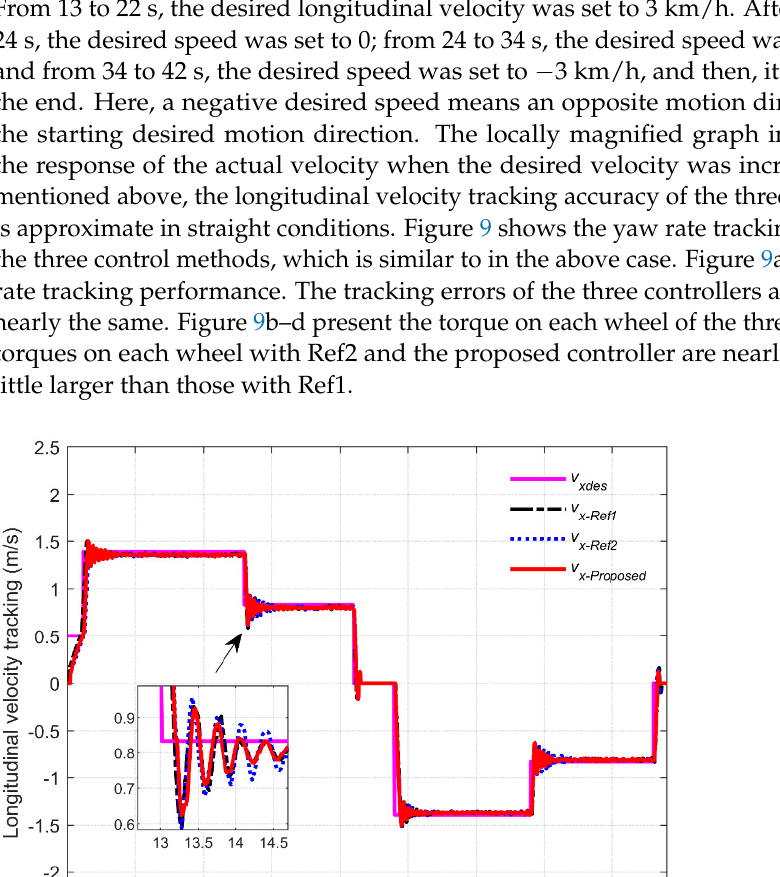
( d ) Figure 9. Comparison of yaw rate and the desired torque on each wheel with three controllers: ( a ) Comparison of yaw rate; ( b ) Torque on each wheel with Ref1 controller; ( c ) Torque on each wheel with Ref2 controller; ( d ) Torque on each wheel with the proposed controller. Figure 10a,b compare the responses to heading and heading error. However, while the yaw rate tracking accuracy is approximately the same for the three control methods in Fig ‐ ure 9, the heading and heading errors are different. Compared to at the starting point, from 0 to 25 s, the heading errors with the Ref1 and Ref2 controllers were almost same, and the maximums were about − 0.94°, but the maximum of the heading error with the proposed controller was about − 0.8°, which was the smallest among the three controllers. After 25 s,